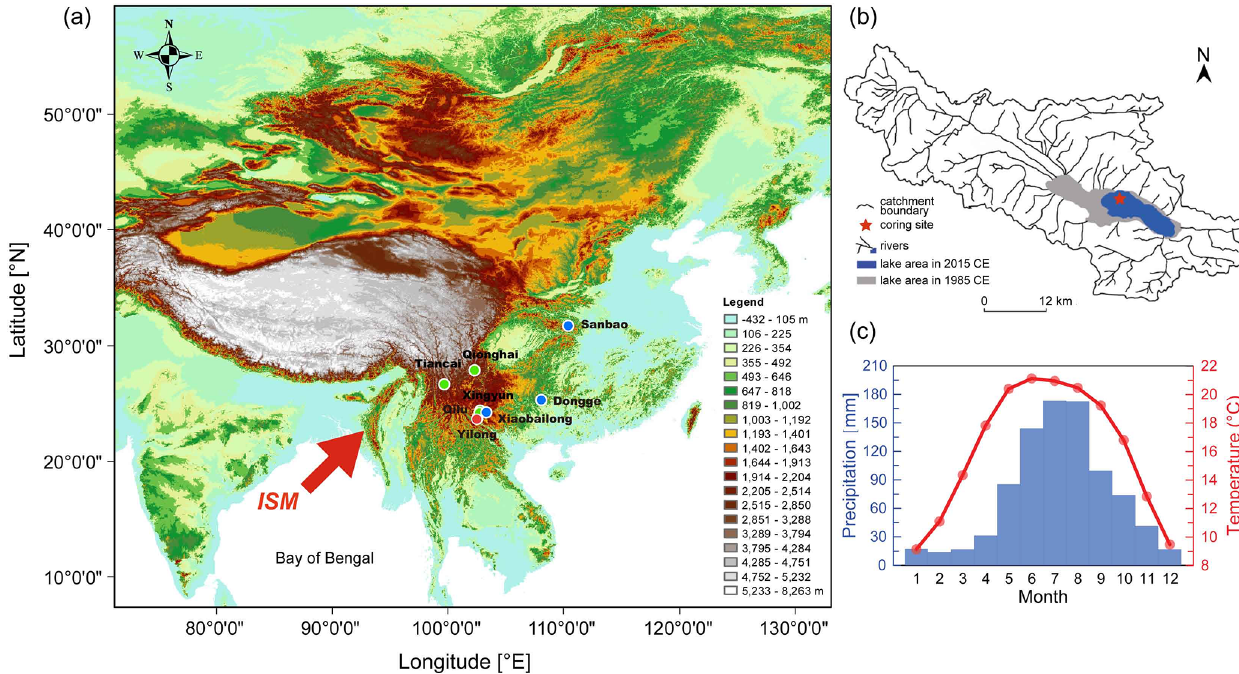
Figure 1. (a) Map showing the location of Yilong Lake and other paleoclimatic records; (b) catchment of the lake and the location of the core YLH; (c) average monthly temperature and precipitation from 1951 to 2017 CE (China Meteorological Data Service Centre, https: //data.cma.cn/en, last access: 26 March